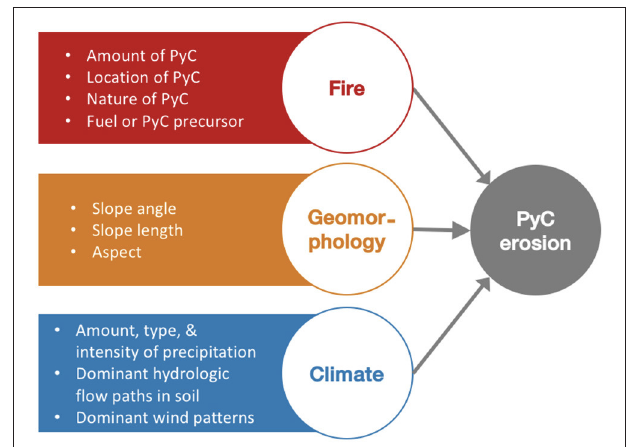
FIGURE 4 | Three main factors interact to control the erosion of PyC in any environment: landscape, climate, and hydrology, and the amount and nature of PyC produced from fire. These three factors interact with each other in both space and time to impact the fate of